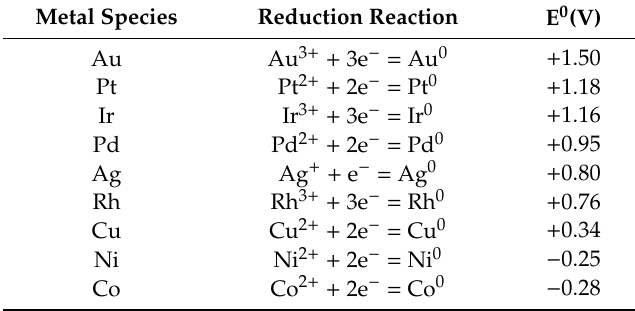
Table 1. Reduction reactions with their corresponding E 0 of common metals.